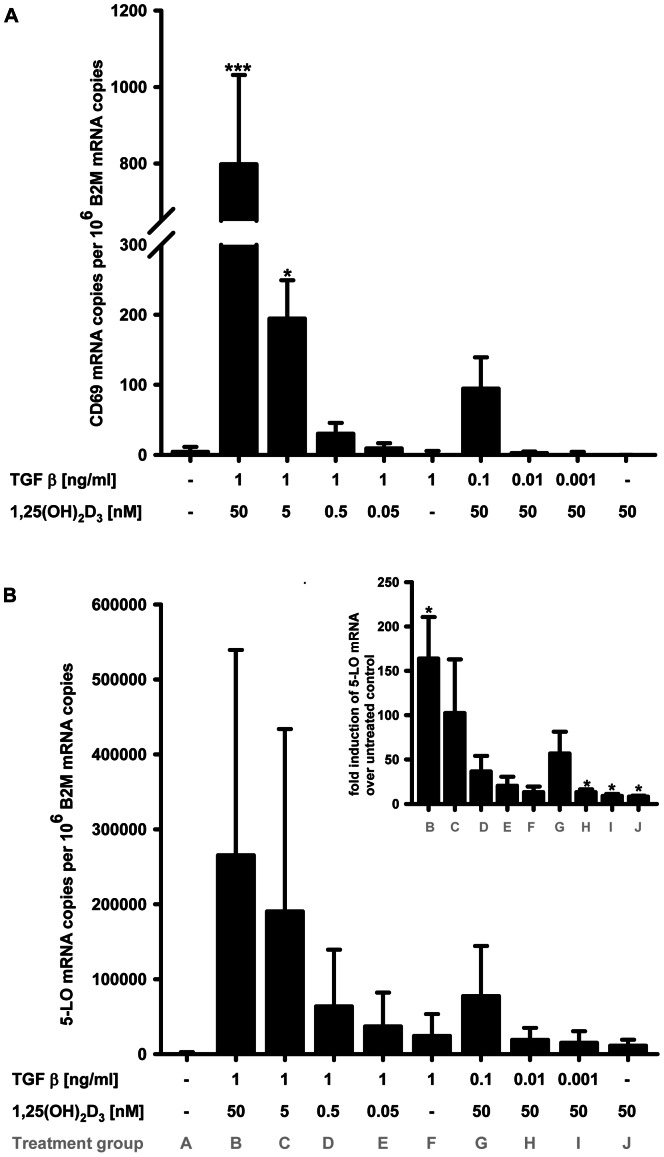
Concentration dependence of CD69 and 5-LO mRNA induction by TGF-β/1α,25(OH)2D3.(A and B) Cells were treated with varying concentrations of TGF-β and 1α,25(OH)2D3 and mRNA levels were determined by qPCR. Concentrations, as indicated after “T” for TGF-β and “V” for 1α,25(OH)2D3, are presented in ng/ml and nM, respectively. The insert in (B) shows fold inductions of 5-LO mRNA over untreated control. One way ANOVA was performed with Dunnett's multiple comparison post test(*P<0.05; ***P<0.001). Fold induction of 5-LO was analyzed with one sample t-test.